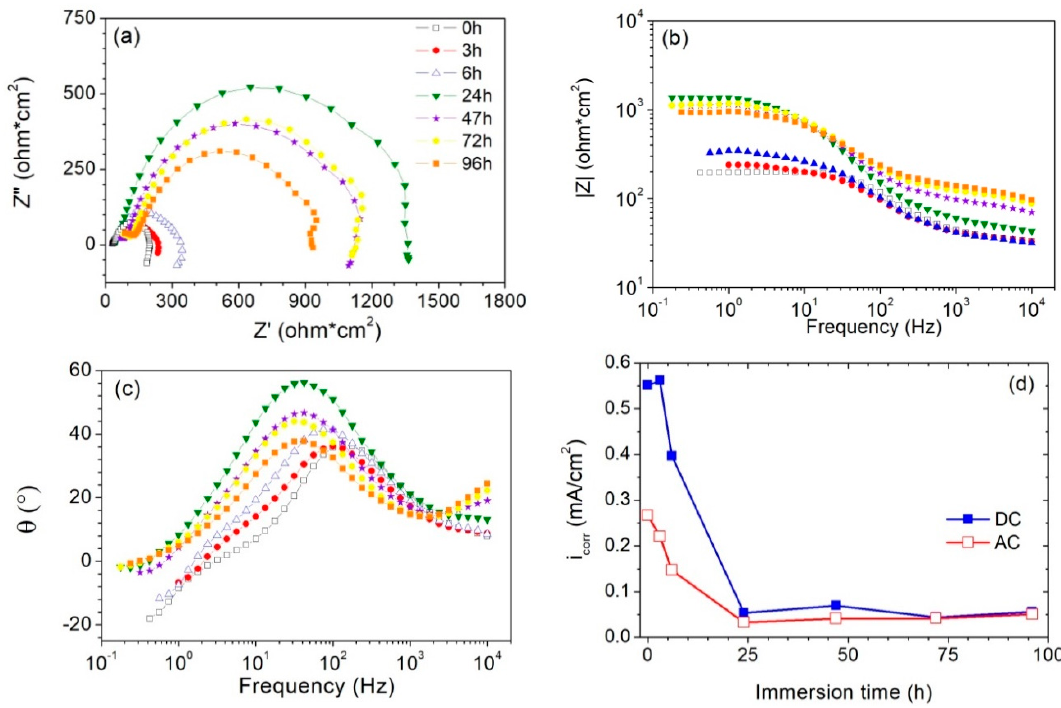
Figure 11. Electrochemical Impedance Spectroscopy of EZ51-IM350 immersed in PBS: ( a ) Nyquist diagram, ( b ) bode diagram of the module, ( c ) bode diagram of the angle, and ( d ) comparison of calculated i corr from Figure 10b and from Nyquist adjustment in Table 3 with B = 45 mV. Table 3. Equivalent circuit of Randles used for fitting the experimental EIS curves of the EZ51-IM350 alloy. The table lists the values of R Ω , R p and C (capacitance). Time Equivalent circuit